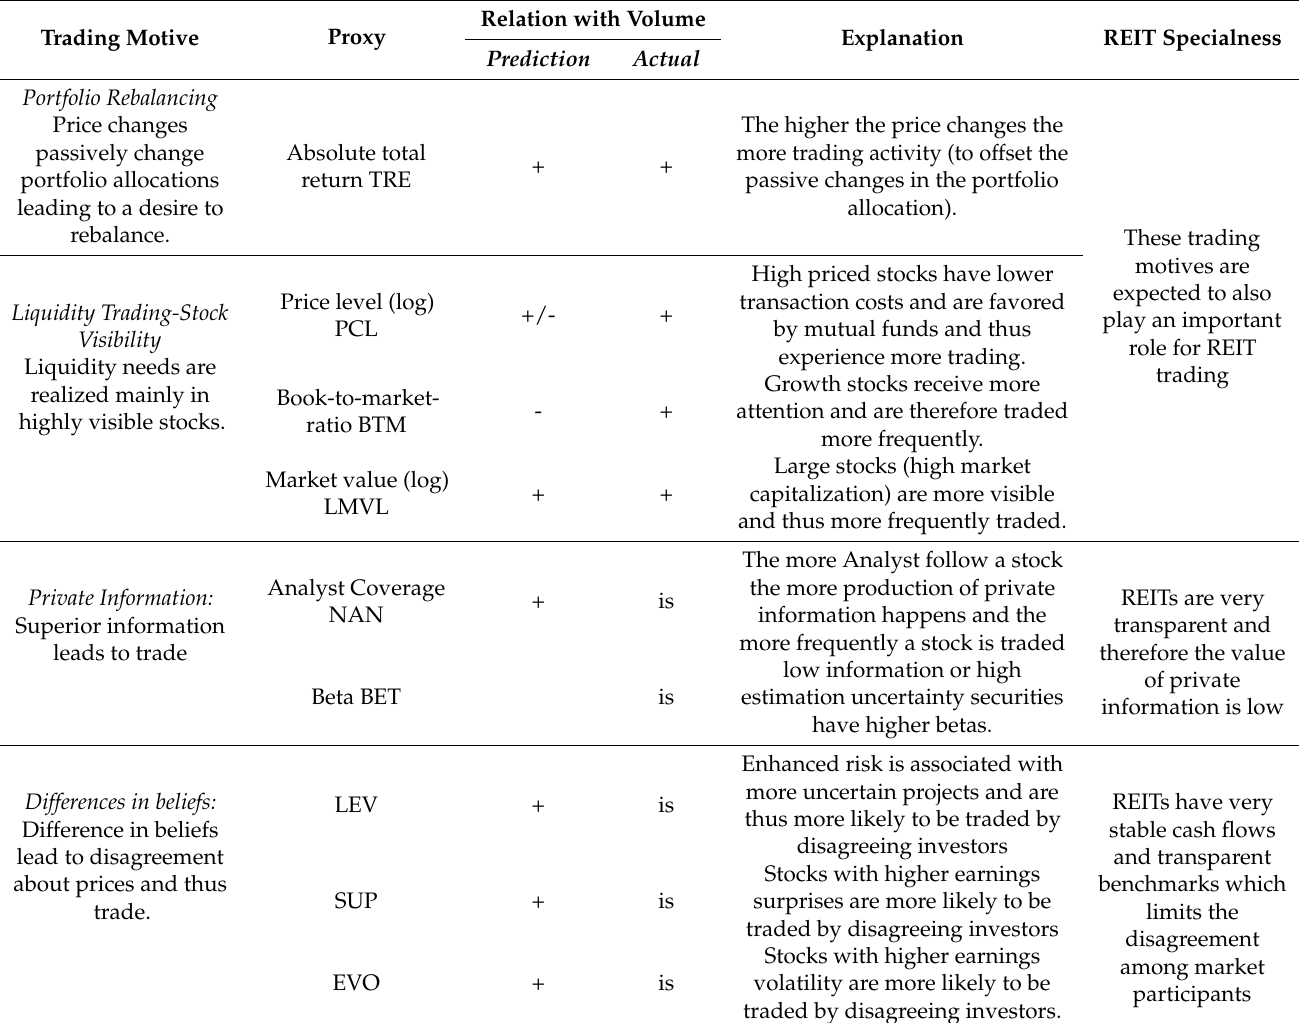
Table 3. Trading Motives, Proxies, Predicted relation and rationale. The first column contains the studied trading motives. The second column names the applied proxies for the trading motives. The third column contains the predicted relation between the proxy and volume by theory. The fourth column states the actual relation between the proxy and volume in REIT markets based on the results of specification 1 in Table 2. A + indicates a positive relation, a - indicates a negative relation and is indicates no significant relation. The fifth column explains why the proxy is related to volume in the postulated way by general market microstructure theory. The sixth column explains why the relation for REIT stocks might deviate from the predictions of general market microstructure theory and previous empirical results in equity